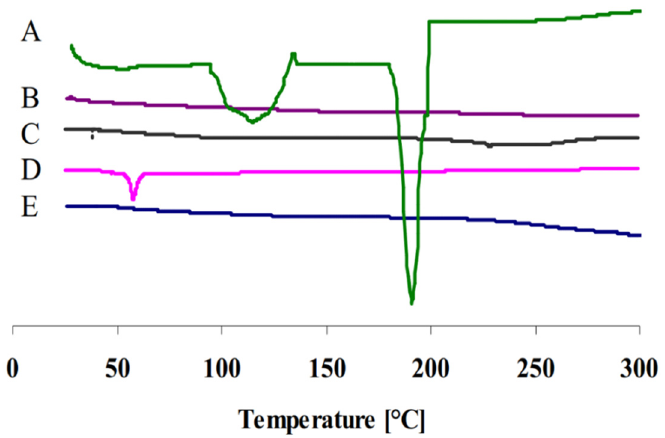
Figure 2. DSC thermograms of (A) pure GTX, (B) GTX-loaded cubosomal dispersion, (C) blank cubosomal dispersion, (D) P407 and (E) GMO. cubosomal dispersion, (D) P407 and (E)